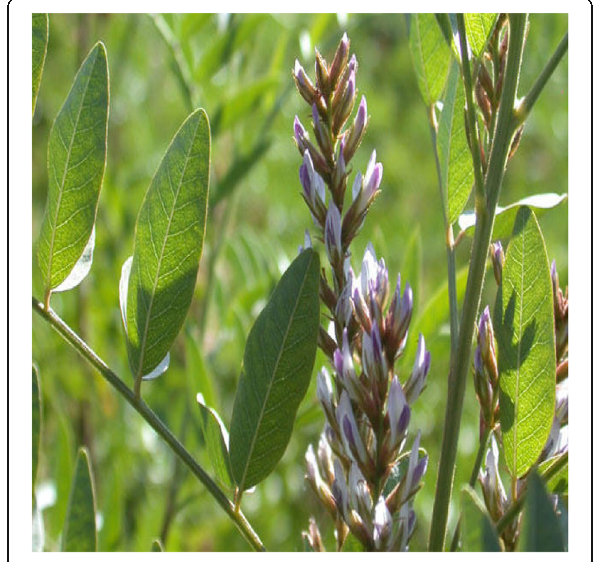
Fig. 8 Glycyrrhiza glabra . This endangered non endemic, rare species belongs to the plant family Leguminosae (Fabaceae or Papilionaceae) (Copy source Jacob Thomas